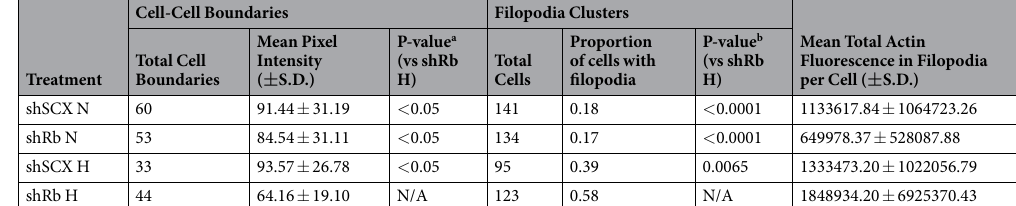
Table 1. Summary of the double blind analysis of actin fluorescence. a P-values were determined using the Kruskal-Wallis with Dunn’s multiple comparisons test. b P-values were determined using the Fisher’s exact test.